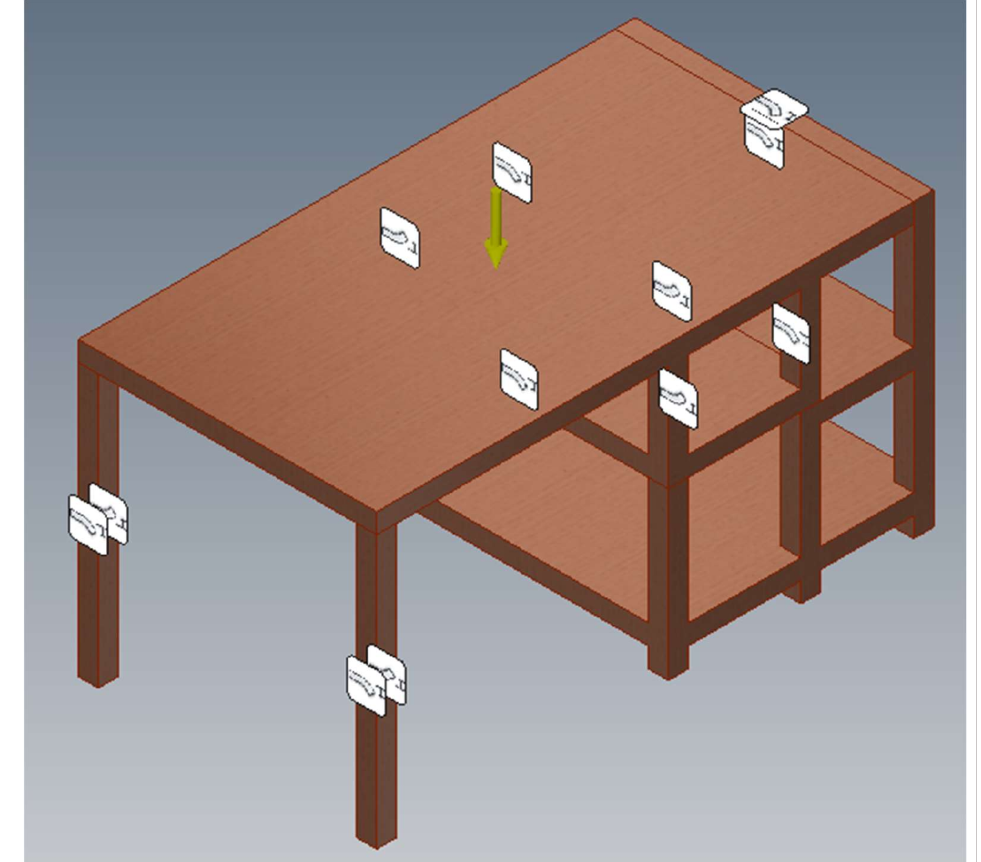
Figure 6. Overview of force applied on table. The simulation results for the von Mises stress and displacement of the table are shown in Figure 7. The maximum stress occurs at the table edge and top surface of the table leg. The stress ranges from 0.2165 to 0.4331 MPa for a simulation with 70 kg, and 0.3712 to 0.7424 MPa for a simulation with 120 kg. These findings indicate that the stresses do not exceed the ultimate tensile strength of the material, which is 5.1 MPa. For displacement results, a maximum deformation of 0.02419 mm is found for the 70-kg simulation. A deformation of 0.04146 mm is found for the 120-kg simulation. These results indicate that the displacements can be neglected since the maximum deformations are small in comparison to the size of the